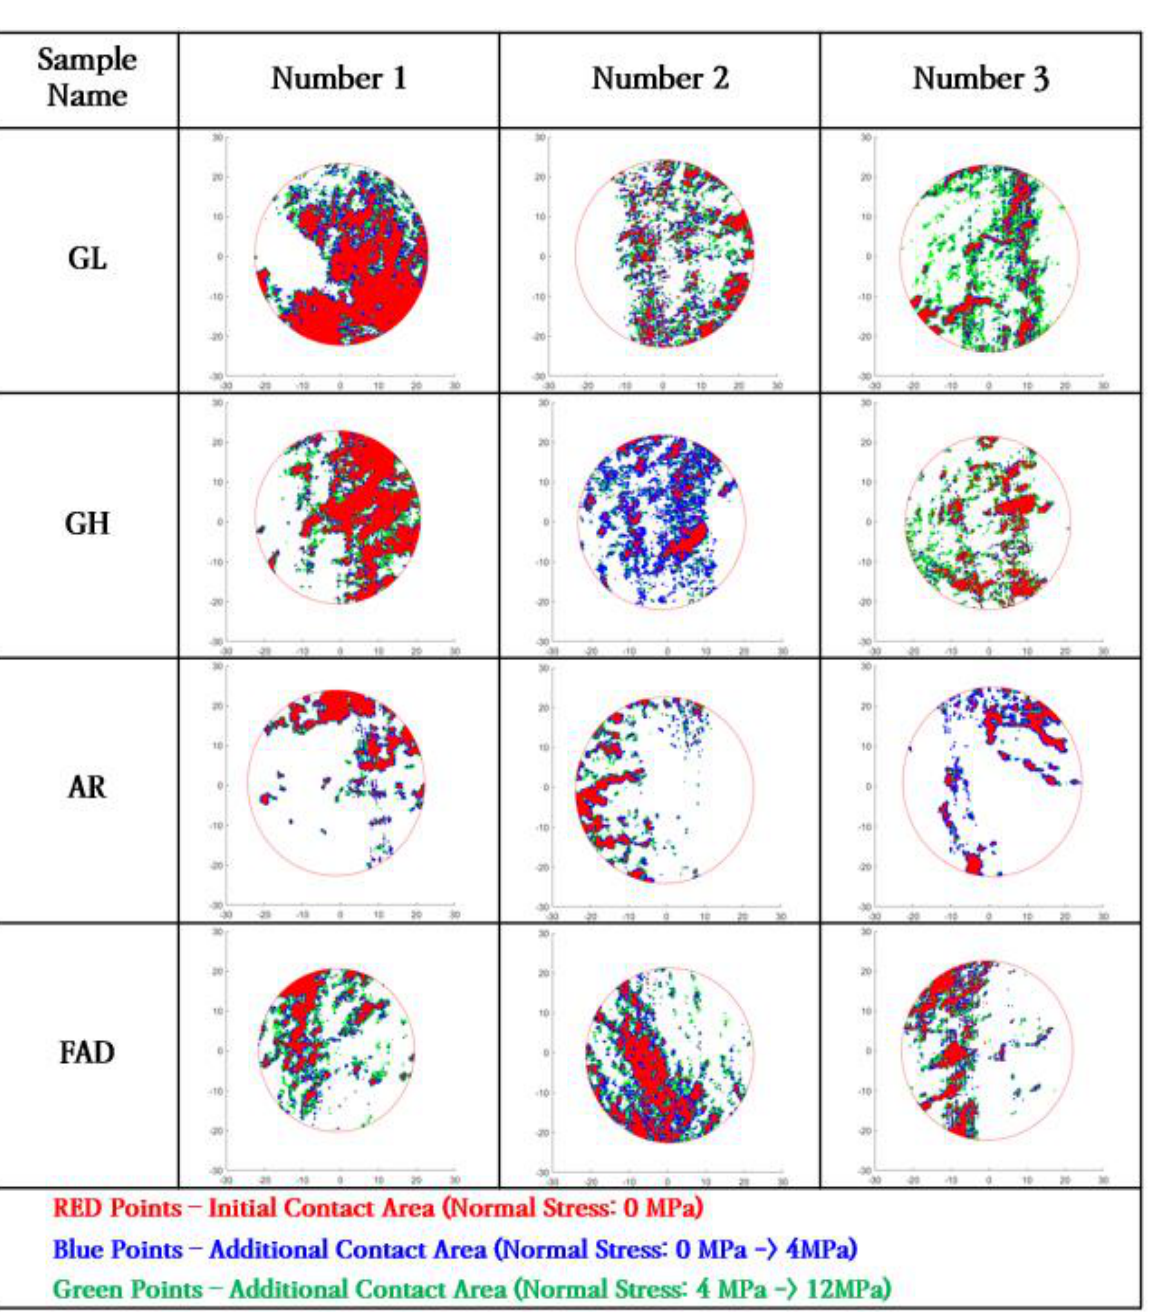
Figure 13. Changes in the contact area with increasing normal stress for natural fracture speci-